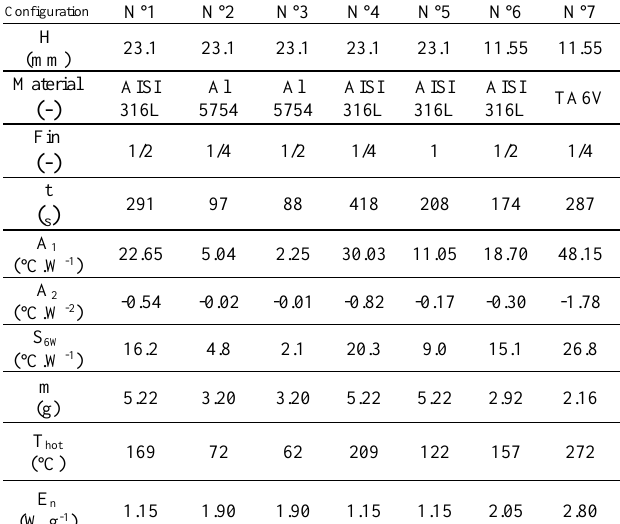
TABLE I METROLOGICAL CHARACTERISTICS FOR SEVEN C ONFIGURATIONS OF A CALORRE CALORIMETRIC CELL Configuration